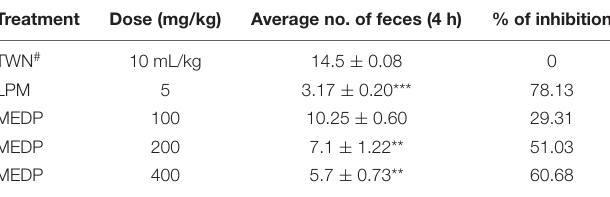
TABLE 3 | Castor oil induced diarrheal test Dillenia pentagyna. Treatment